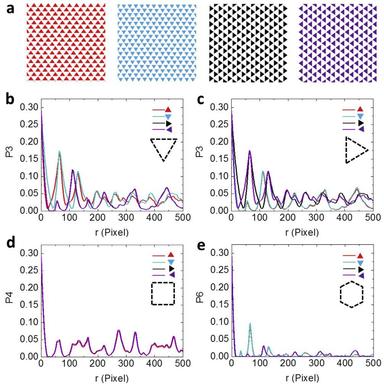
(a) Model microstructures composed of congruent equilateral triangle particles with different orientations arranged on a triangular lattice. The resolution of the images is 1048 by 1048 pixels. (b) Directional 3-point polytope functions P3 for the model microstructures associated with vertically oriented triangular sampling templates. (c) Directional 3 point polytope functions P3 for the model microstructures associated with horizontally oriented triangular sampling templates. (d) 4-point polytope functions